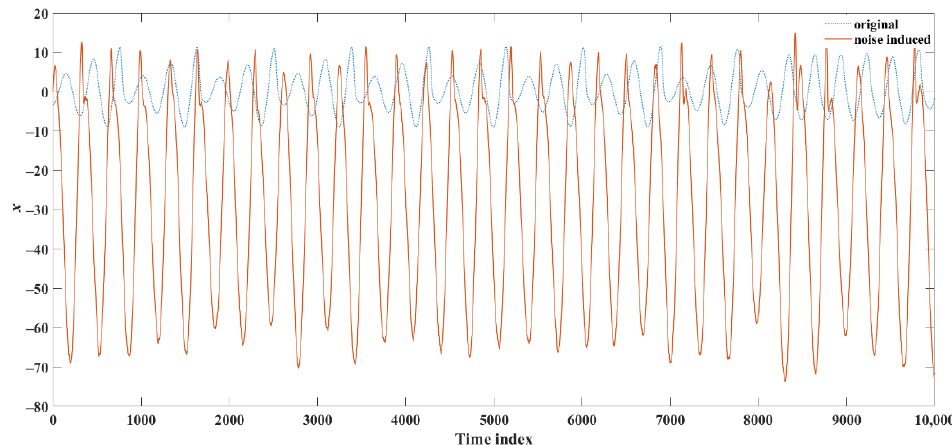
Figure 3. Examples of a segment of the original (blue dotted line) and noisy (red solid line) x time series generated using the chaotic Rössler model.